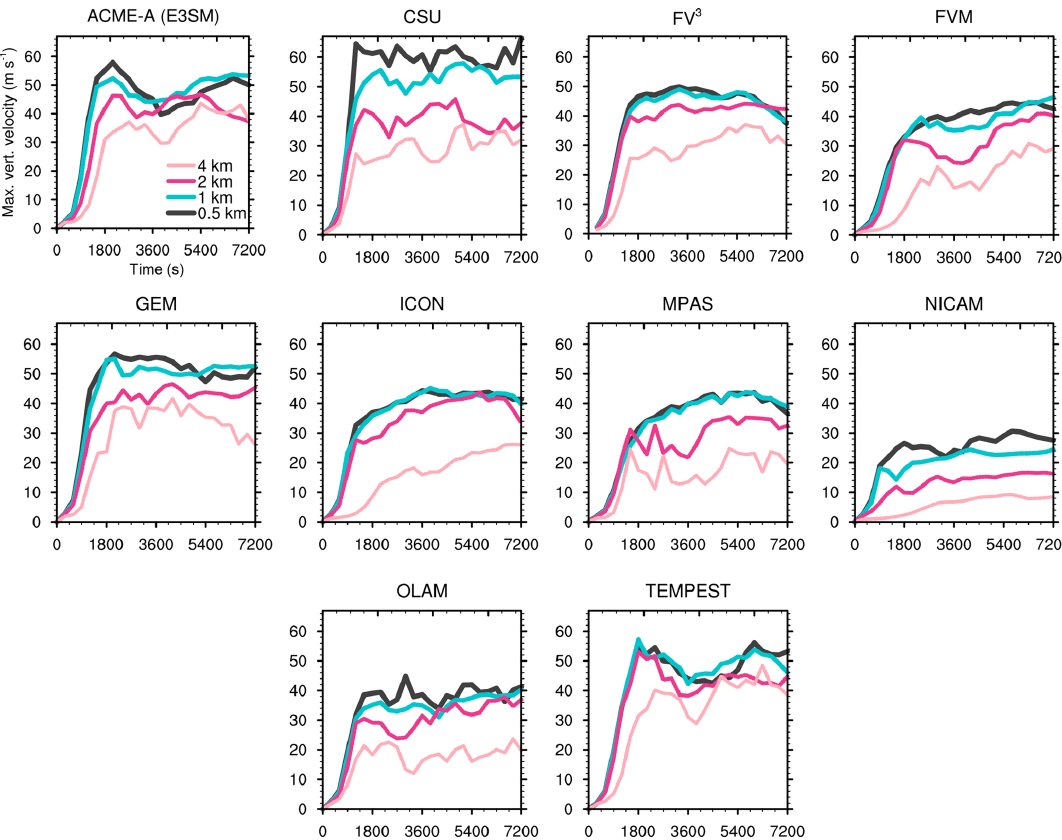
Figure 5. Maximum domain updraft velocity (ms − 1 ) as a function of time (seconds from initialization) for each model at each of the four specified resolutions. Note that the dark grey line is the finest grid spacing (0.5km) in this